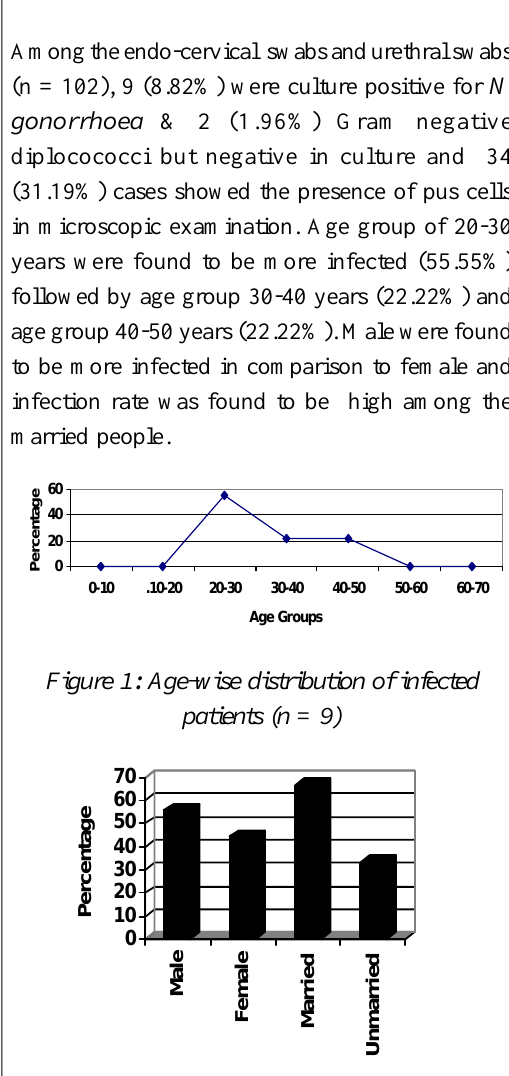
Table I : Occupational Status of the Infected